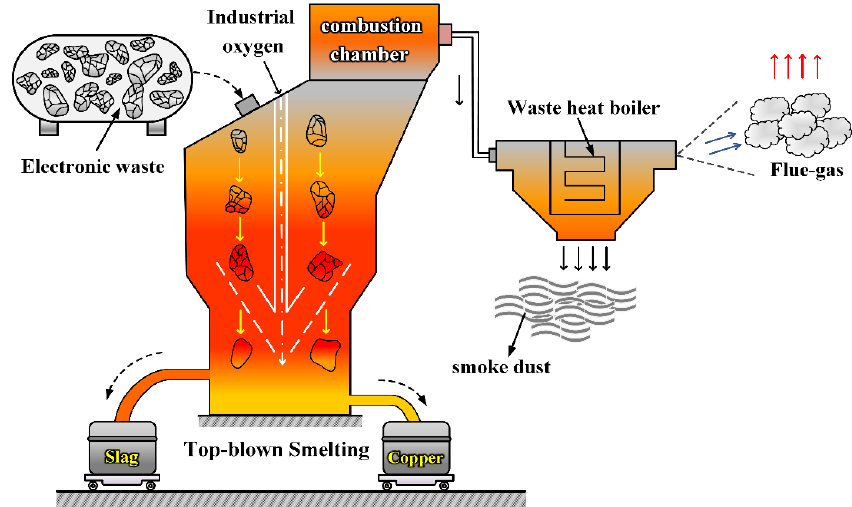
Figure 1. Flow chart of the top-blowing smelting system of electronic waste.